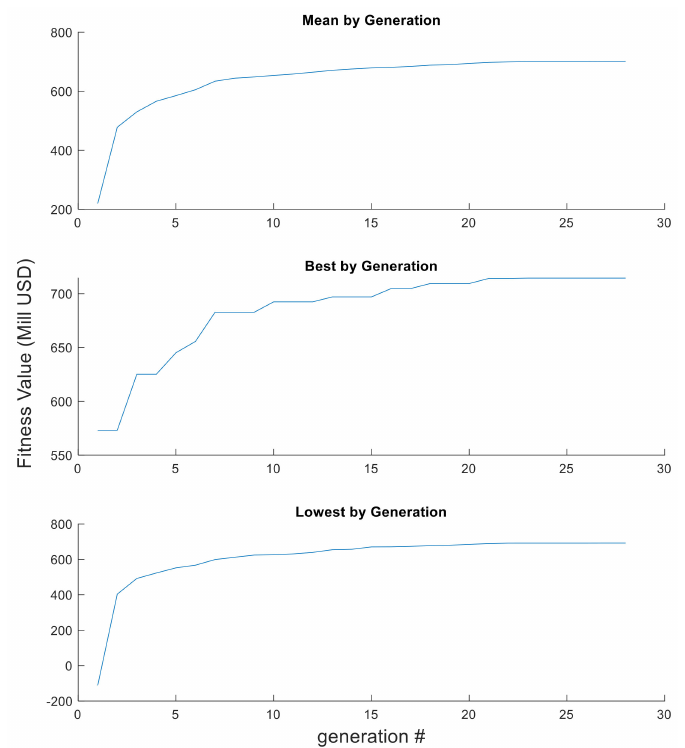
Figure 17. Example of the evolution of the fitness